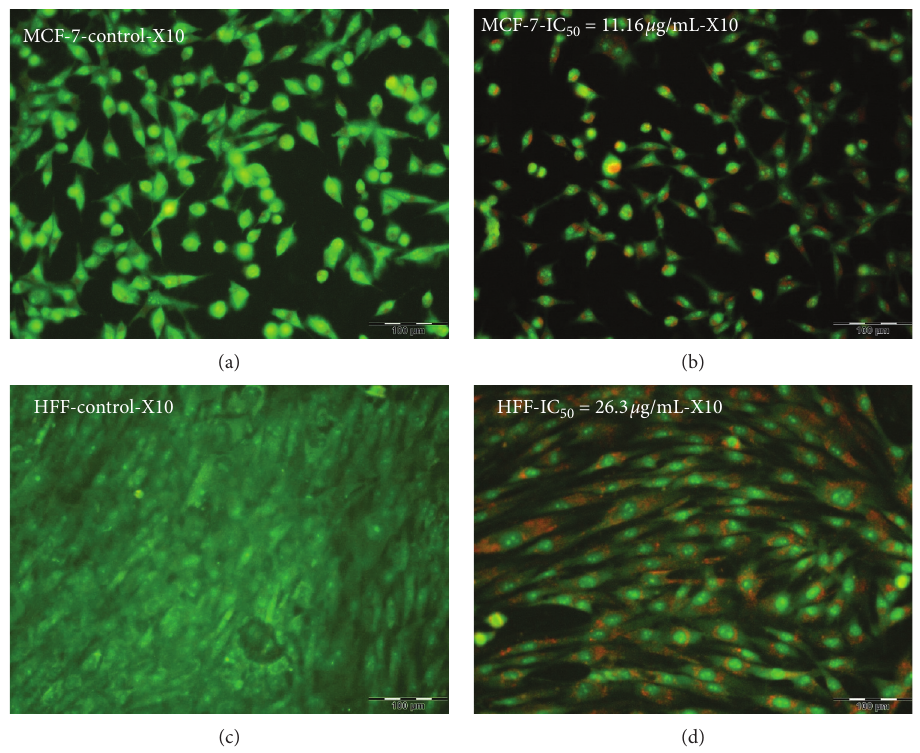
Figure 4: Effect of zinc oxide nanoparticles on apoptotic morphological changes in MCF7 and HFF cell lines by AO/PI staining. (a) Untreated MCF7 cells. (b) Morphology of the MCF7 cells after ZnO-NP treatment with IC 50 dose (IC 50 � 11.16 μ g/mL). (c) Untreated HFF cell morphology. (d) HFF cells’ morphology after ZnO-NP treatment with IC 50 dose (IC 50 � 26.3 μ